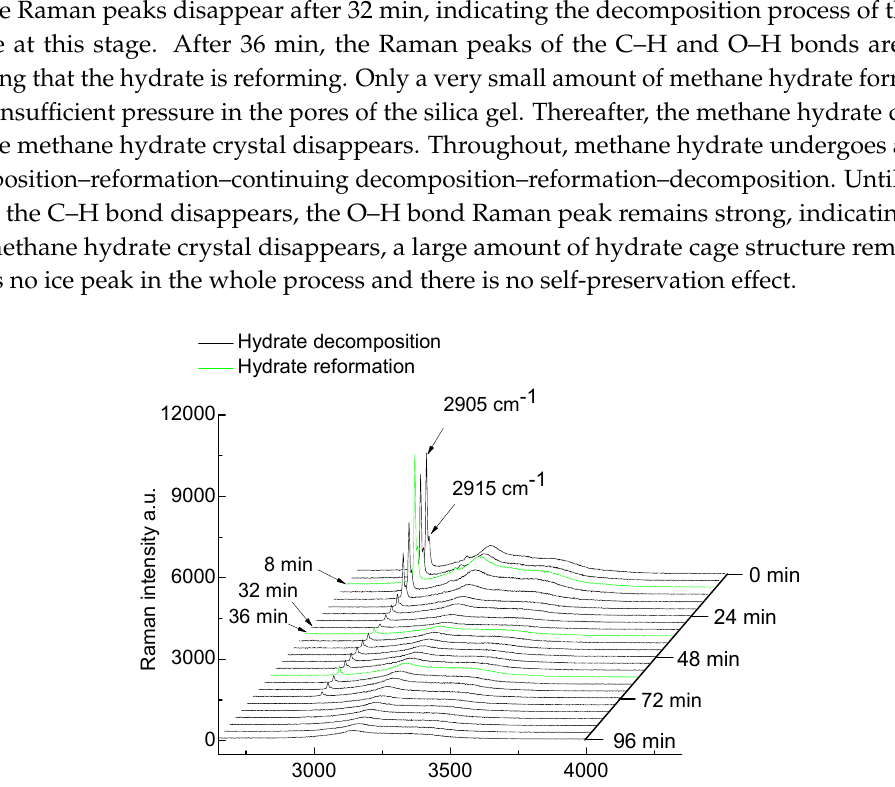
Figure 5. Methane hydrate decomposition at 245 K and atmospheric pressure.